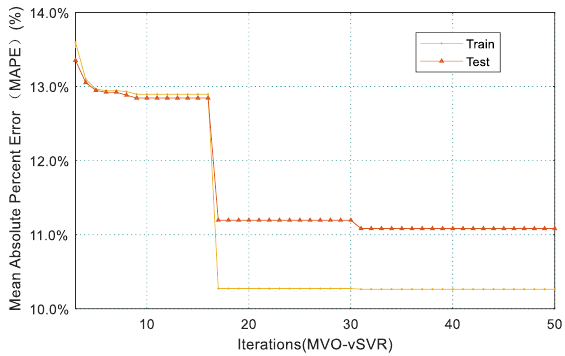
Figure 6. MAPE curve for optimization of v -support vector regression ( v SVR) parameters.